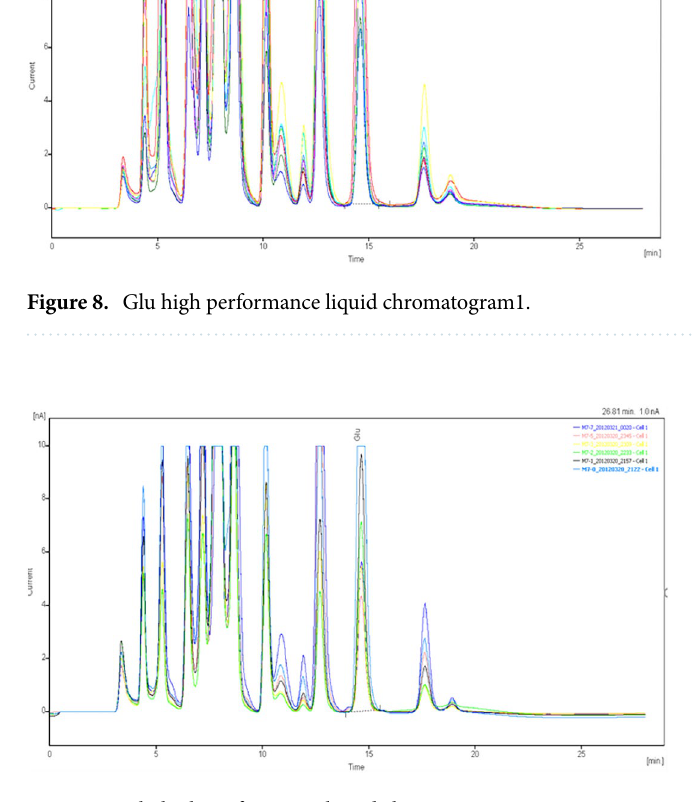
Figure 9. Glu high performance liquid chromatogram2.